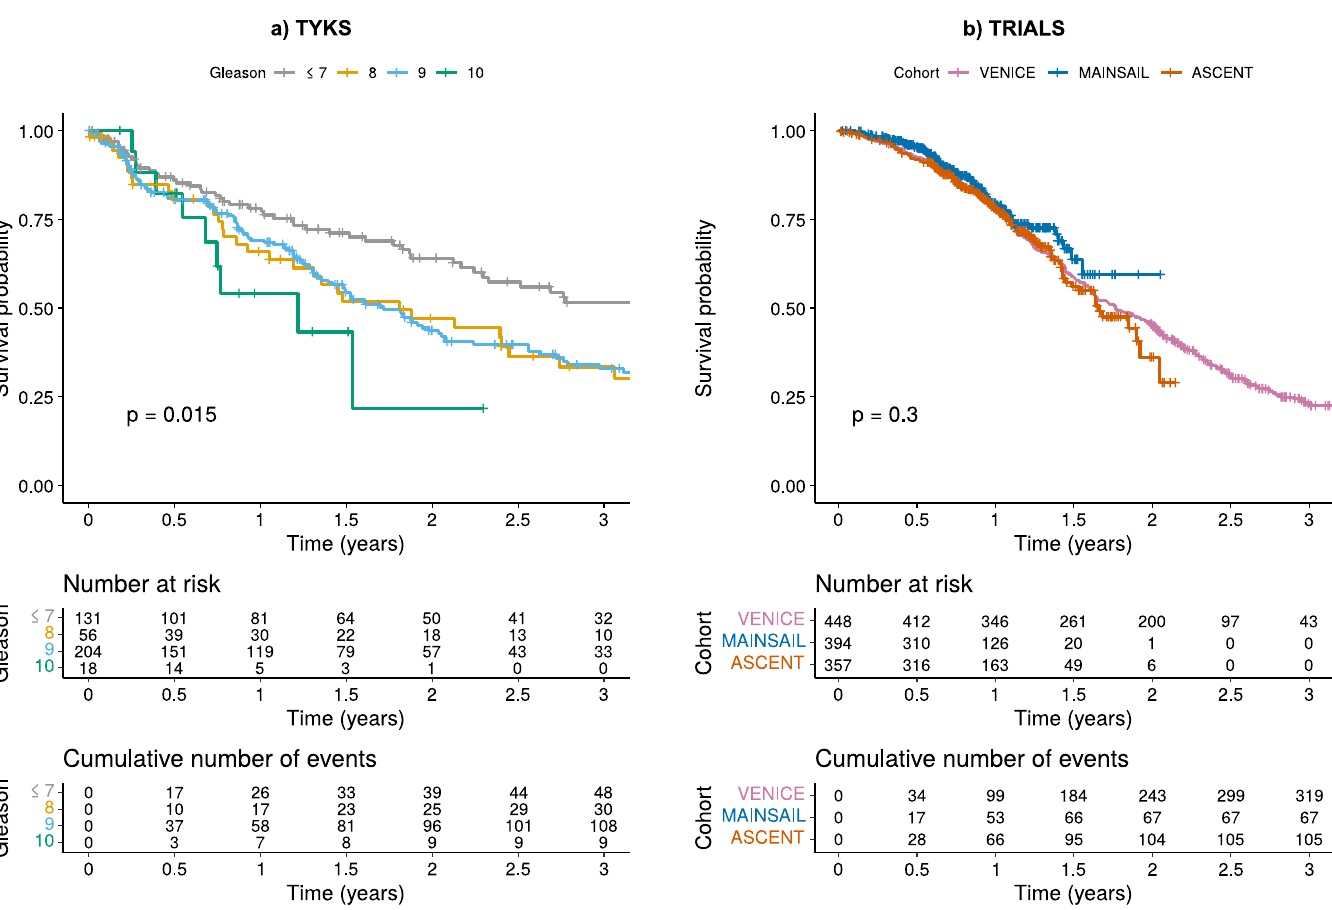
Fig 2. Survival curves: a) Kaplan-Meier survival probability for the TYKS patient cohort based on the Gleason scores. b) Kaplan-Meier survival probability for the three clinical trial cohorts: VENICE, MAINSAIL, and ASCENT.